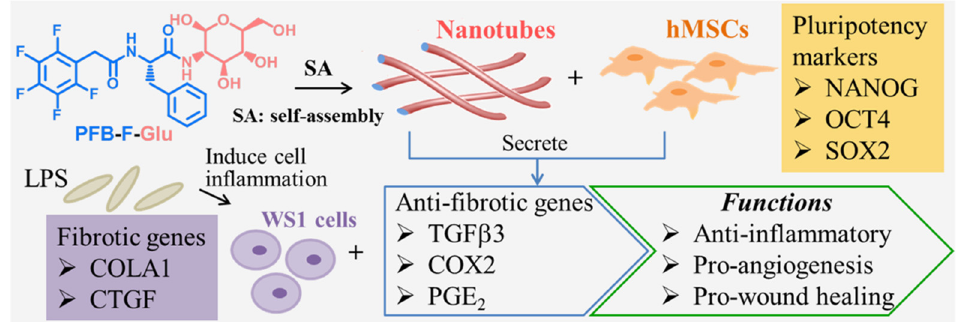
Figure 5. Glucosamine-based supramolecular nanotube formation and research strategy for stem cell therapy. PFB-F-Glu (pentafluorobenzyl-phenylalanine-glucosamine) nanotubes are shown to enhance hMSC (human mesenchymal stem cells) proliferation while maintaining their pluripotency. The hMSCs cultured on PFB-F-Glu nanotubes could secrete paracrine factors to suppress pro-fibrotic gene expression in lipopolysaccharide (LPS)-treated human skin fibroblasts (WS1), indicating the nanotubes have the potential for wound healing treatment. OCT4: octamer-binding transcription factor 4; SOX2: SRY (sex determining region Y)-box 2; COLA1: collagen α 1 chain; CTGF: connective tissue growth factor; TGF β 3: transforming growth factor β 3; COX2: cyclooxygenase 2; PGE 2 : prostaglandin E 2 . Reprinted with permission from Talloj, S.K.; Cheng, B.; Weng, J.-P.; Lin, H.-C. (2018). Copyright 2018 ACS Applied Materials & Interfaces, American Chemical Society [121].